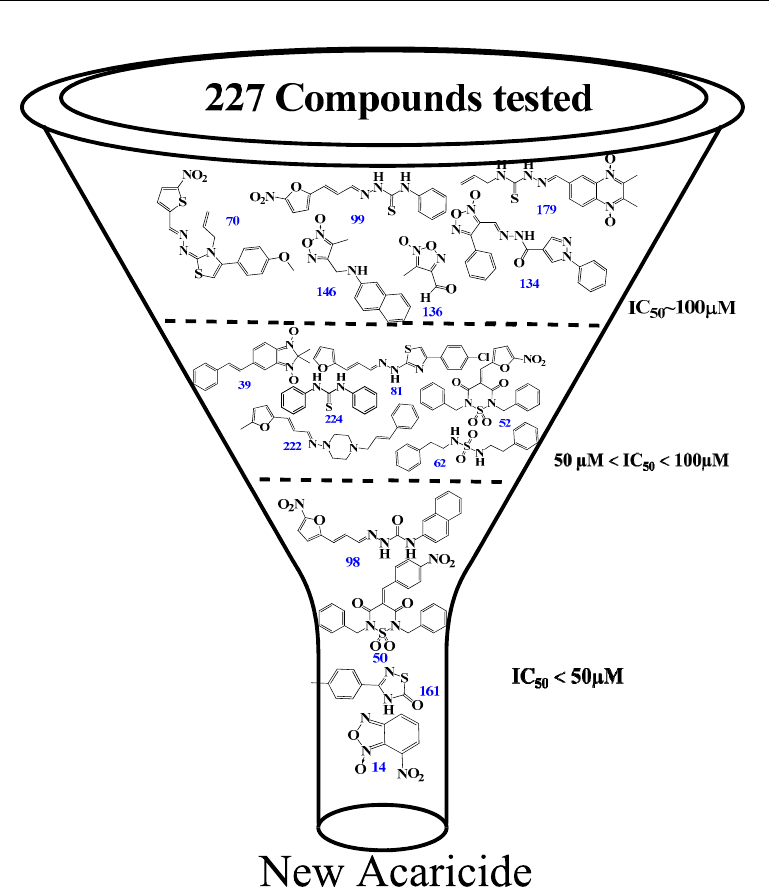
Figure 3. Inhibition results on Rm TIM. Structures of the best Rm TIM inhibitors are identified herein.